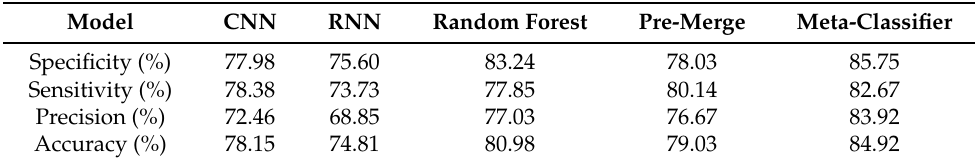
Table 5. Training results for the proposed sleep-arousal detector.